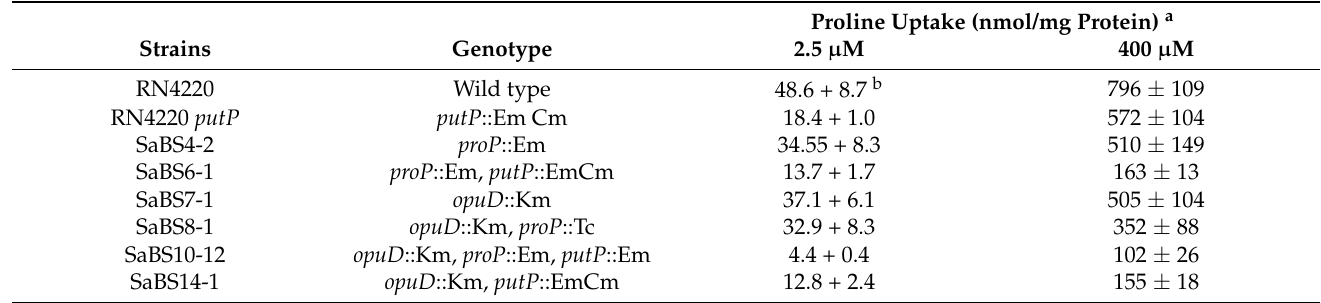
Table 2. Radioactive proline uptake in Staphylococcus aureus proline transport mutant strains over a 30-s time